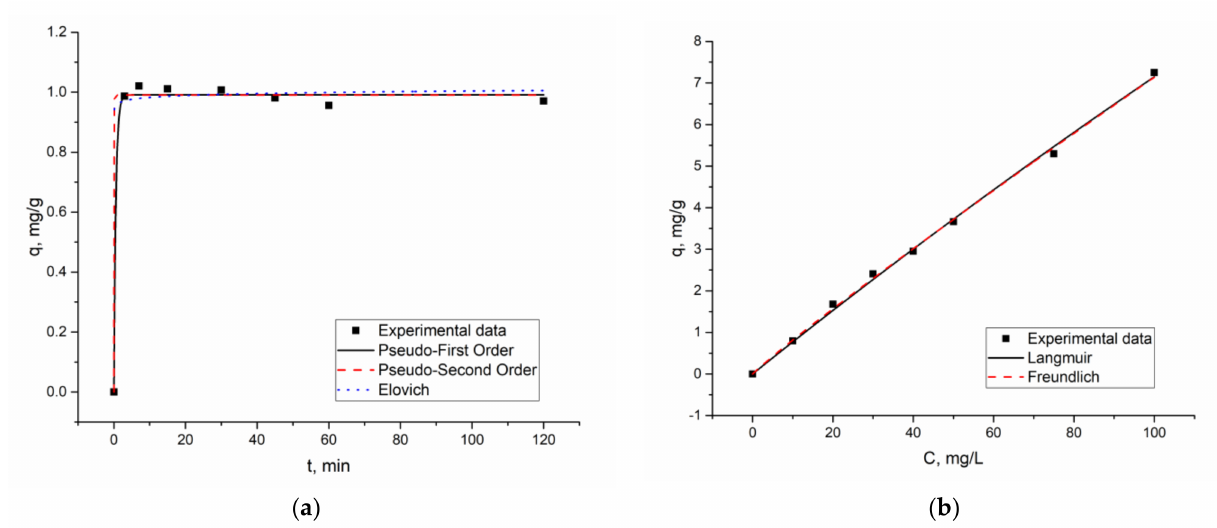
Figure 2. ( a ) Kinetics and ( b ) isotherms of Eu(III) biosorption on S. platensis biomass. Three classical kinetic models were applied to describe Eu(III) biosorption (Figure 2a).